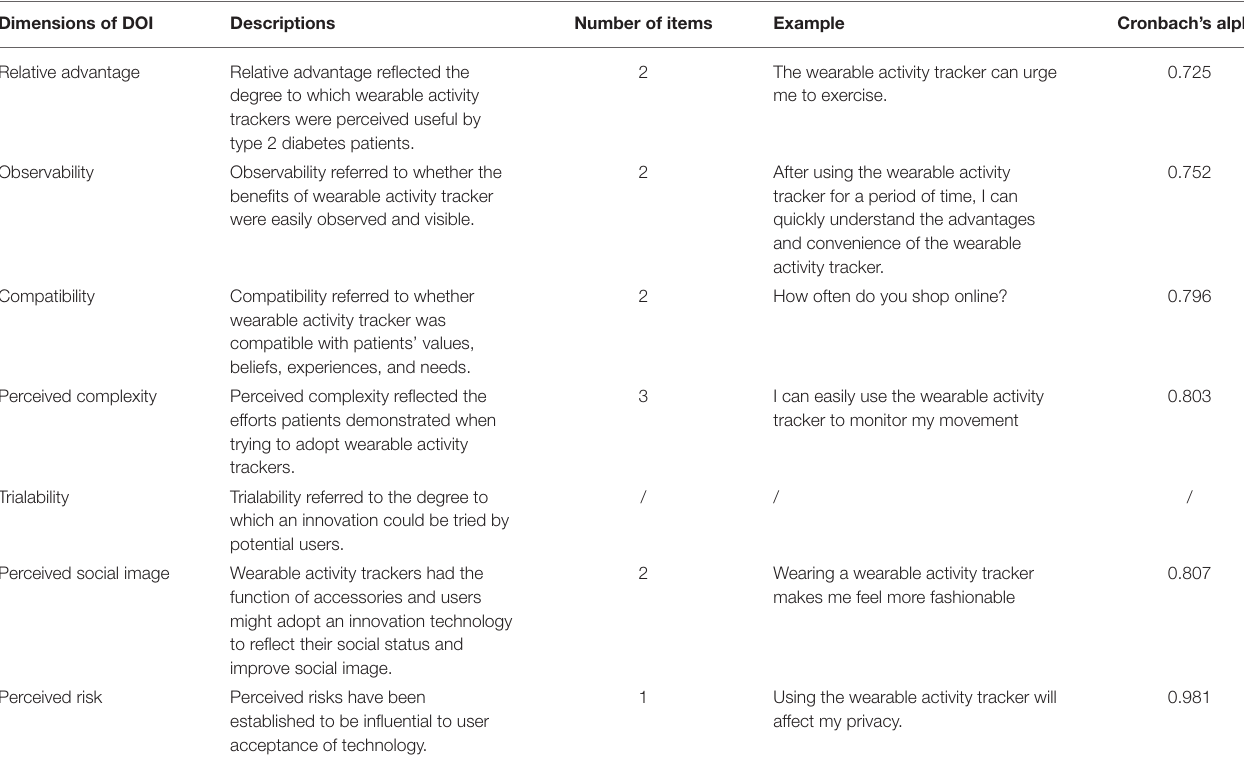
TABLE 1 | Dimensions of diffusion of